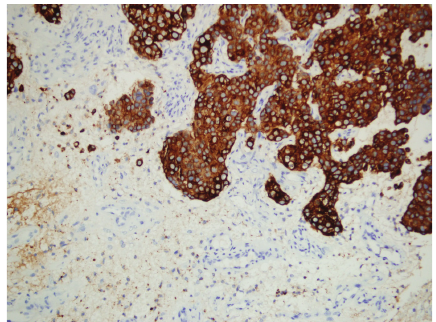
Figure 4: Cytokeratin expression in tumor tissue (pancytokeratin, ×